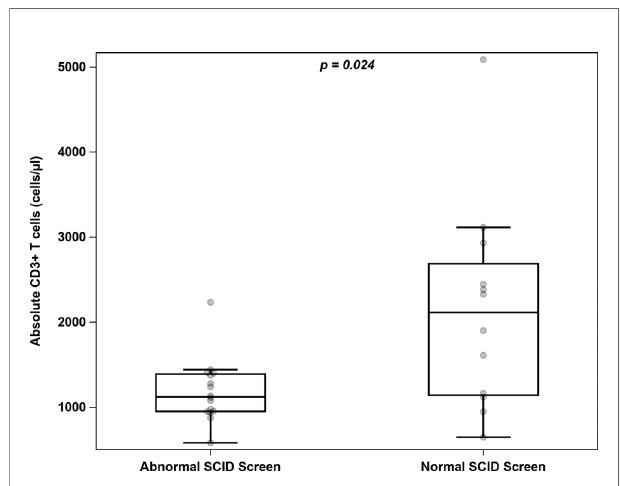
FIGURE 3 | Distribution of absolute T cell counts among infants with 22q11 deletion and either abnormal or normal newborn SCID